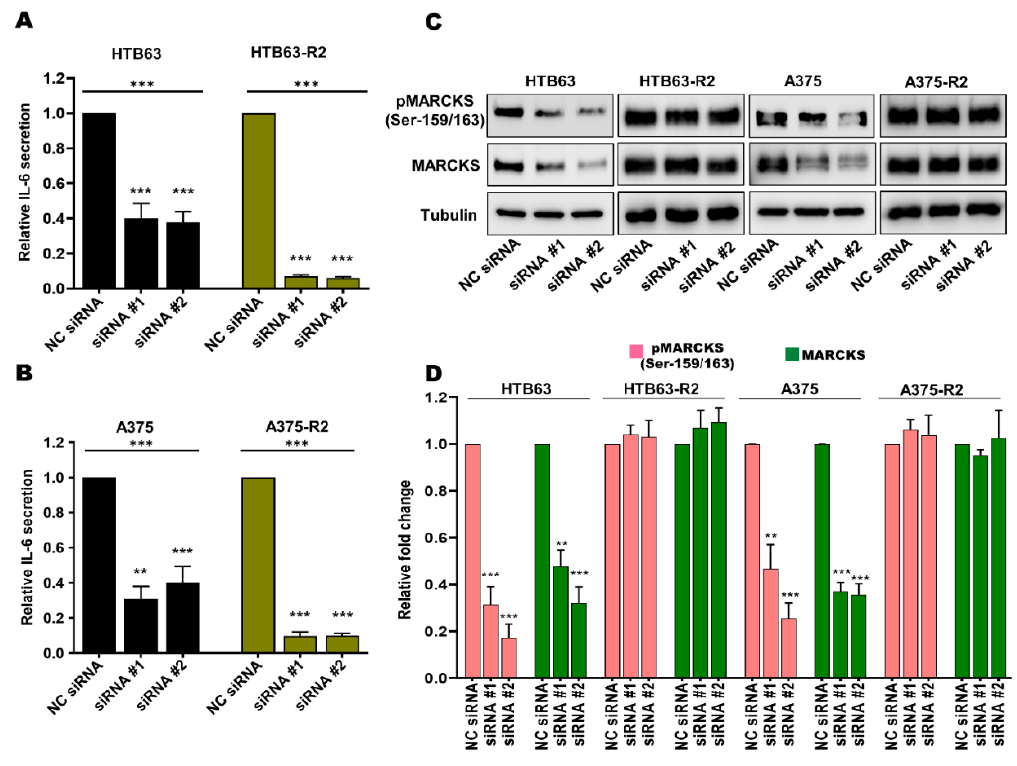
Figure 4. The increased levels of total MARCKS and active phospho-MARCKS are independent of the elevated IL-6 secretion in BRAFi-R melanoma cells. ( A , B ) ELISA-based analysis showing the secreted IL-6 level in BRAFi-sensitive HTB63 and BRAFi-R HTB63-R2 cells ( A ), and in BRAFi-sensitive